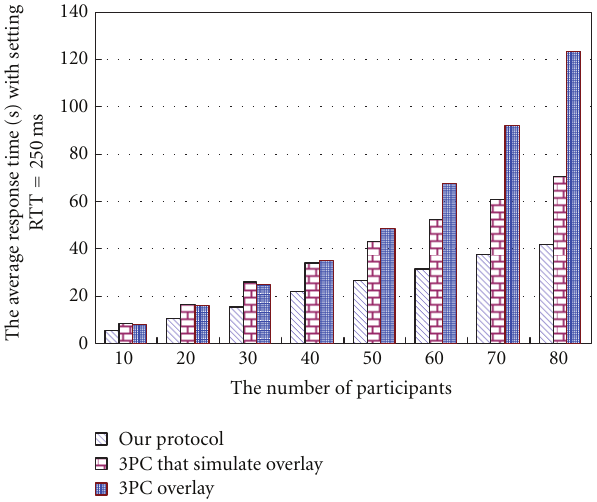
Figure 5: The average response time for each protocol.